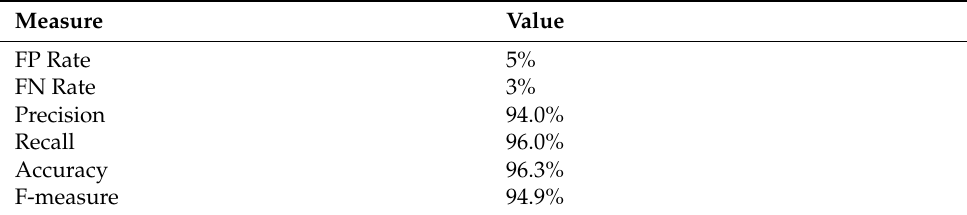
Table 5. Results of malware detection using